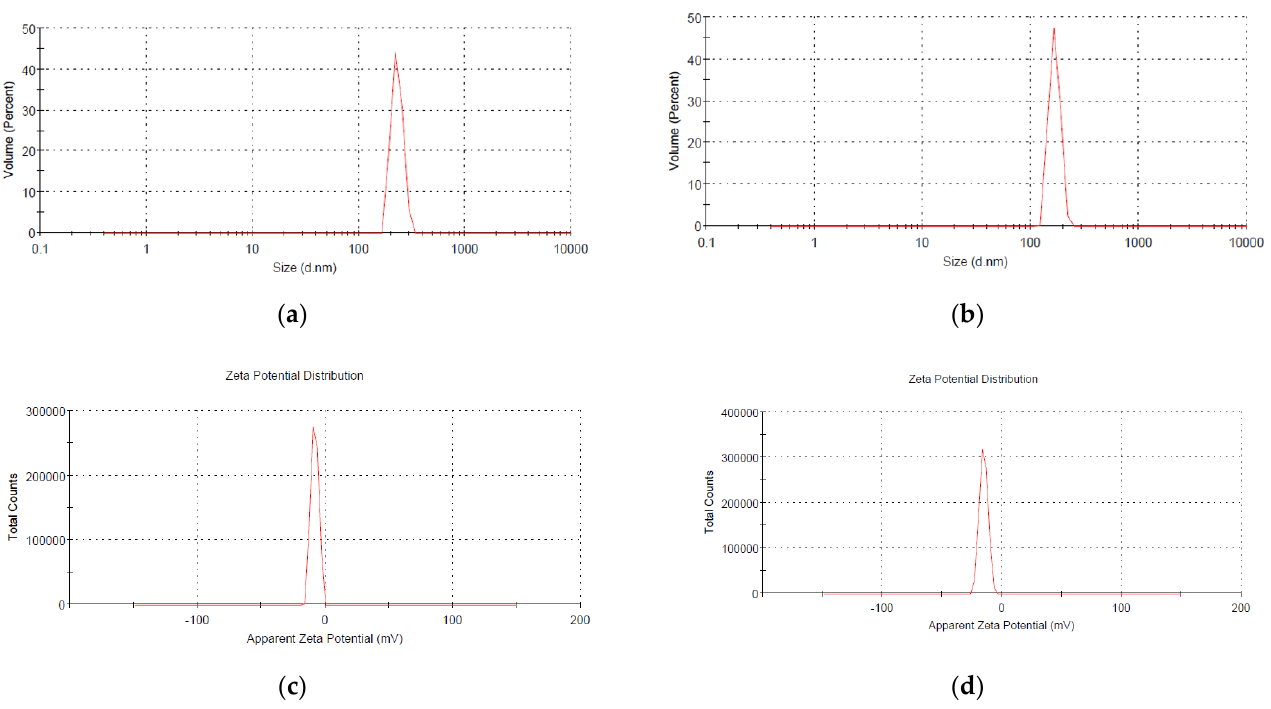
Figure 3. The average size of green synthesized ( a ) nHAPs_PPE (229.6 nm) and ( b ) nHAPs_CE (167.5 nm). Zeta potential of ( c ) nHAPs_PPE ( − 9.37 mV) and ( d ) nHAPs_CE ( − 16.9 mV).